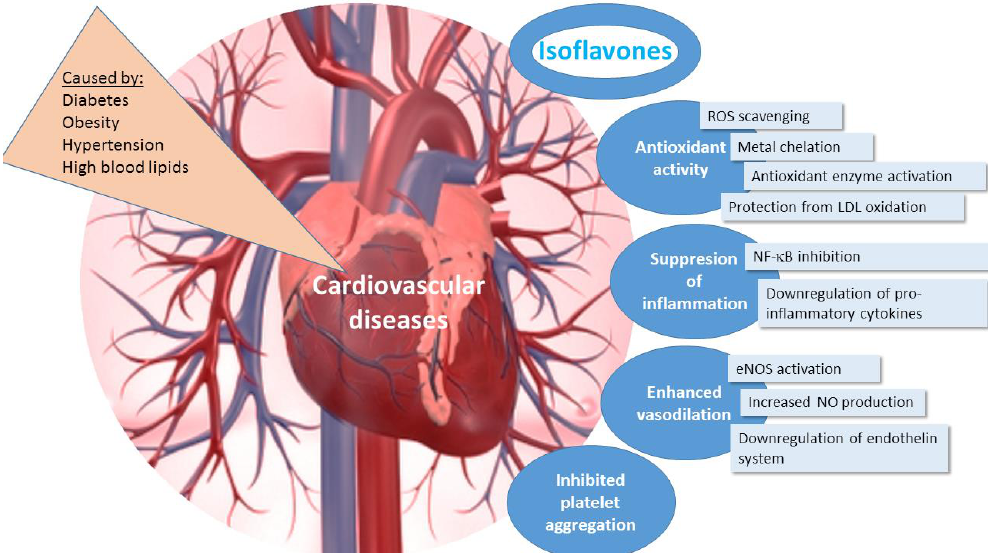
Figure 5. The effects of isoflavones in cardiovascular diseases. ROS—reactive oxygen species, LDL—low density lipoprotein, NF- B—nuclear factor kappa B, eNOS—endothelial nitric oxide synthase, NO—nitric oxide.